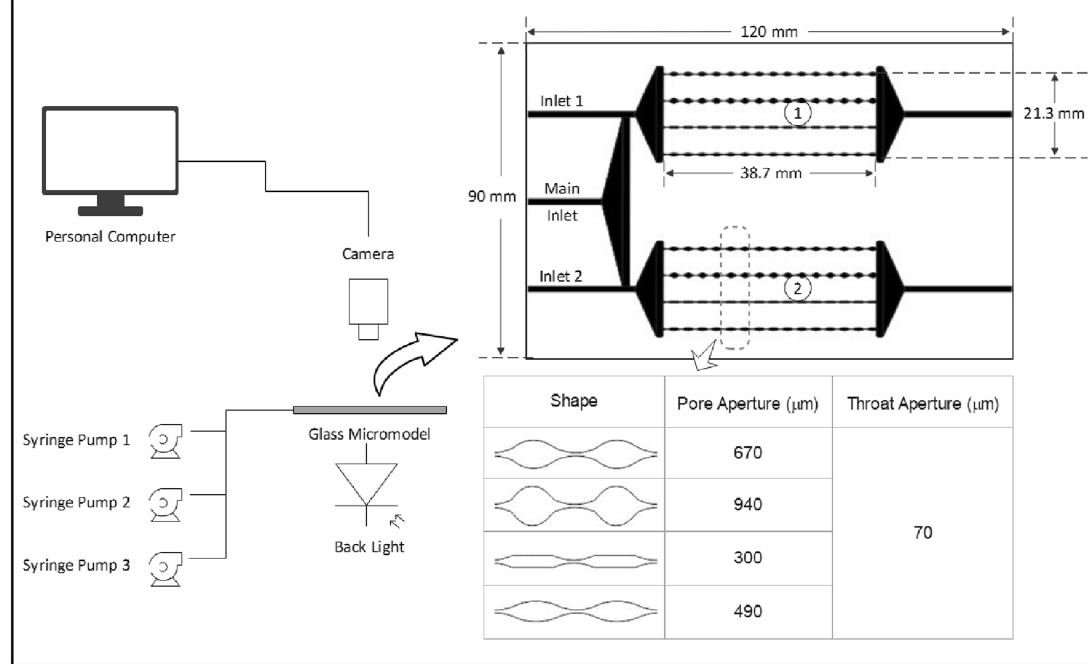
Figure 1. Setup of displacement study in glass